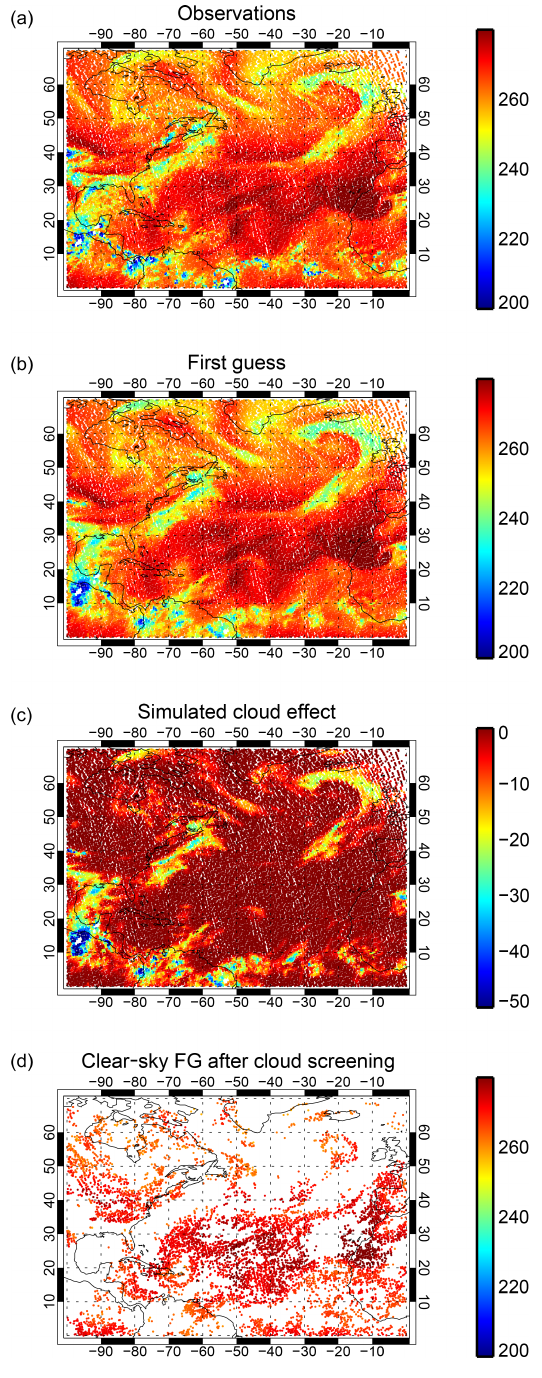
Figure 5. Observations and simulated brightness temperatures, in kelvin, from IASI channel 2889 on Metop-A and Metop-B between 21:00UTC on 31 May 2017 and 09:00UTC on 1 June 2017. VarBC bias correction is applied to the simulated brightness temperatures in panels (b) and (d) . The cloud effect in panel (c) is computed as the simulated clear-sky minus all-sky brightness